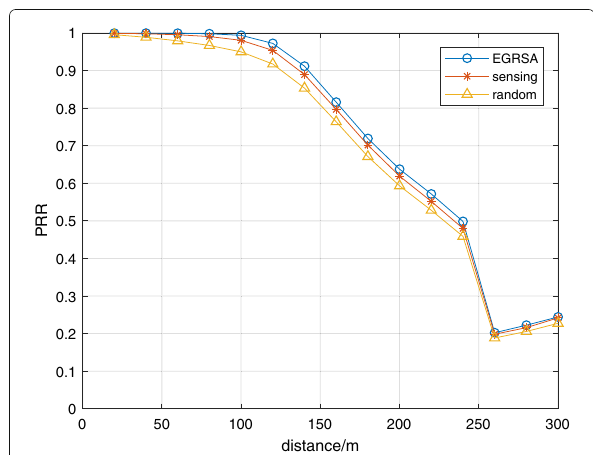
Fig. 12 The PRR of EGRSA. The packet reception ratio (PRR) curve changes with distance. Sensing algorithm and random selection algorithm are selected as comparisons. The line with blue circles represents the proposed enhanced geo-based resource selection algorithm (EGRSA). The line with red stars represents the sensing algorithm. The line with yellow triangles represents the random selection algorithm